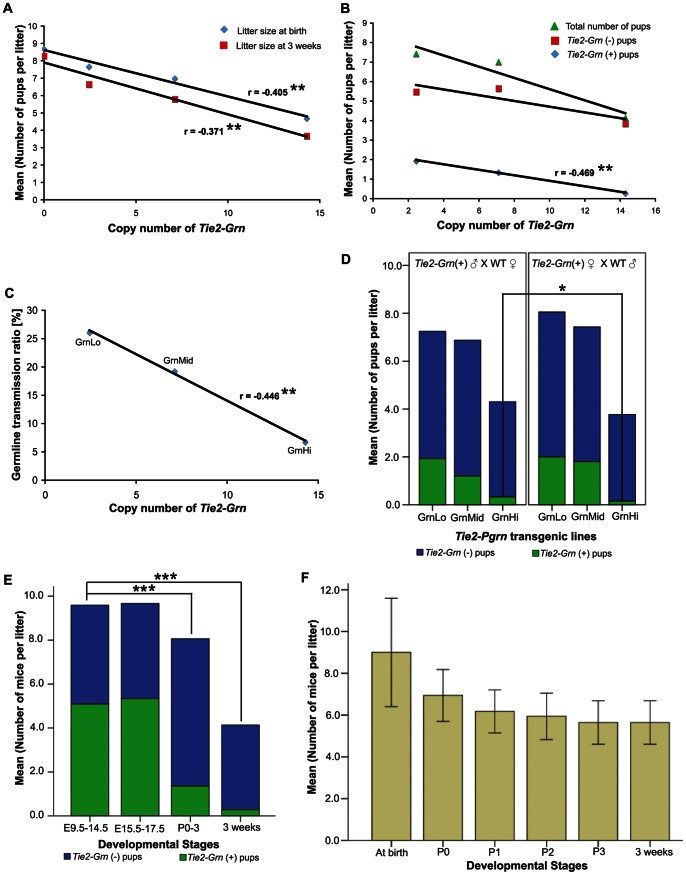
The Tie2-Grn transgene results in elevated mortality during perinatal period.(A) Mean litter size at birth and weaning decreases as a function of higher Tie2-Grn copy number. N = 1220 pups. Correlation between litter size at birth and copy number is significant at the 0.01 level (2 tailed), R = −0.405. Correlation between litter size at weaning and copy number is significant at the 0.01 level (2-tailed), R = −0.371. (B) Comparison of survival statistics for the total number of pups per litter, Tie2-Grn negative pups per litter and Tie2-Grn positive pups per litter at weaning. N = 1069. Correlation is significant between Tie2-Grn positive litter size and copy number at the 0.01 level (2-tailed), R = −0.469. (C) Comparison of germline transmission at weaning of the Tie2-Grn gene expressed as a function of copy number number. N = 1069. Correlation is significant between germline transmission ratio and copy number at the 0.01 level (2-tailed), R = −0.446. (D) Litter sizes from matings with Tie2-Grn positive father or mother. Independent samples T-test was performed for individual transgenic lines. p = 0.260 (GrnLo); p = 0.095 (GrnMid). A slight maternal effect was observed in the GrnHi line (p = 0.041). (E) Litter sizes (Tie2-Grn positive and negative) throughout development. N = 653 pups, GrnHi line. Independent samples T-test for variable (%Tg) was conducted between groups E9.5–14.5 vs. E15.5–17.5 (p = 0.8); E9.5–14.5 vs. P0–3 (p<0.001); and E9.5–14.5 vs. 3 weeks (p<0.001). (F) Death continued after birth (newborn), and the first, second and third days of life. Thereafter, most mice survived to weaning. Error bars denote +/−95% C.I. N = 17, GrnHi line. Asterisks indicate statistical significance in 2A–D; significance of <0.001 is ***, <0.01 is ** and <0.05 is *.